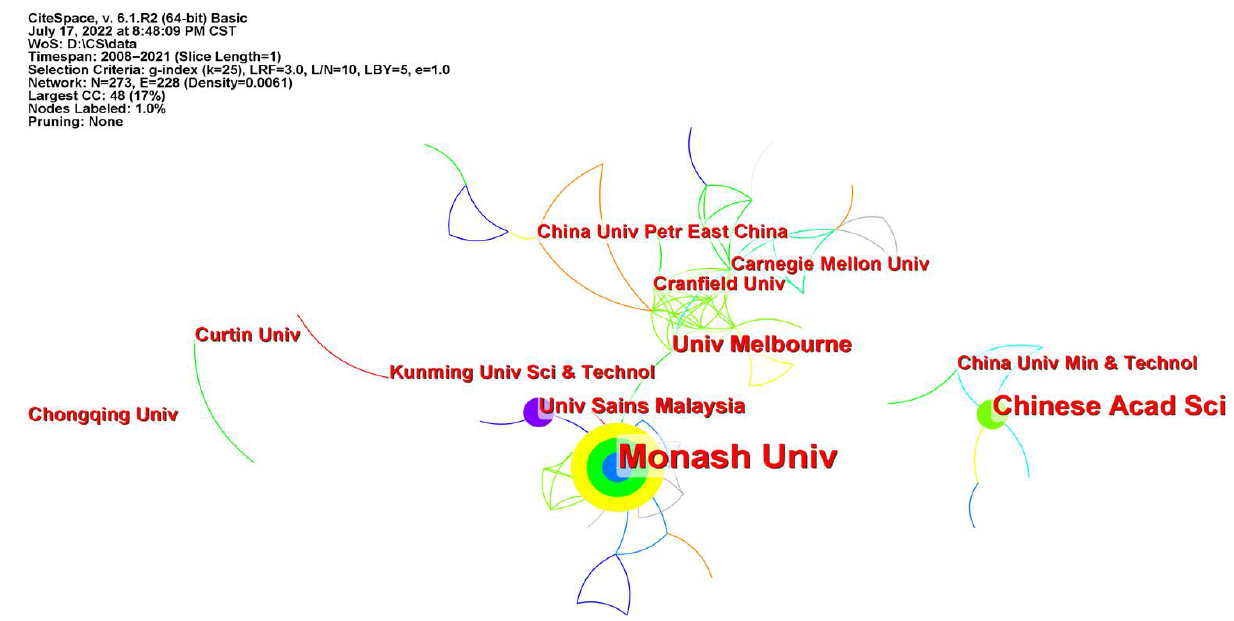
Figure 25. Organization co-occurrence map.